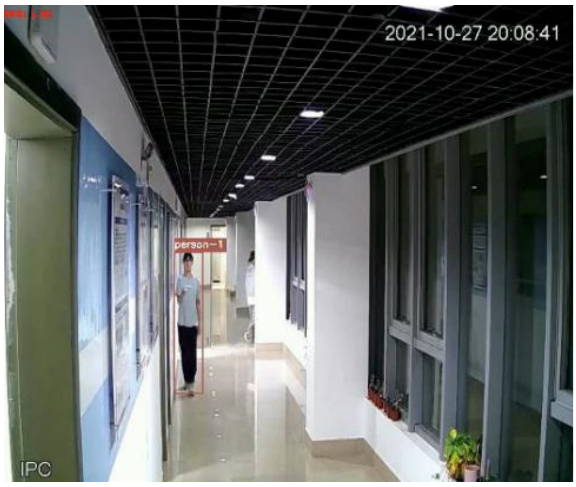
Figure 8. Experimental Scenario 2.